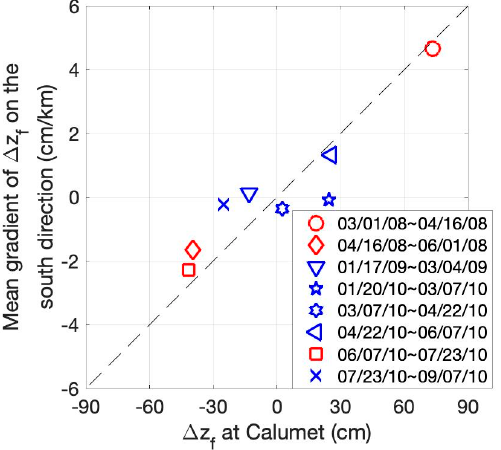
Figure 18. The projection on the south direction ( − ˆ y ) of the mean gradient of water level change retrieval over swamps, ∇ ∆ z · ( − ˆ y ) , plotted against the water level change ∆ z f at Calumet. Red markers show InSAR pairs where we observe significant patterns in Figure 15.